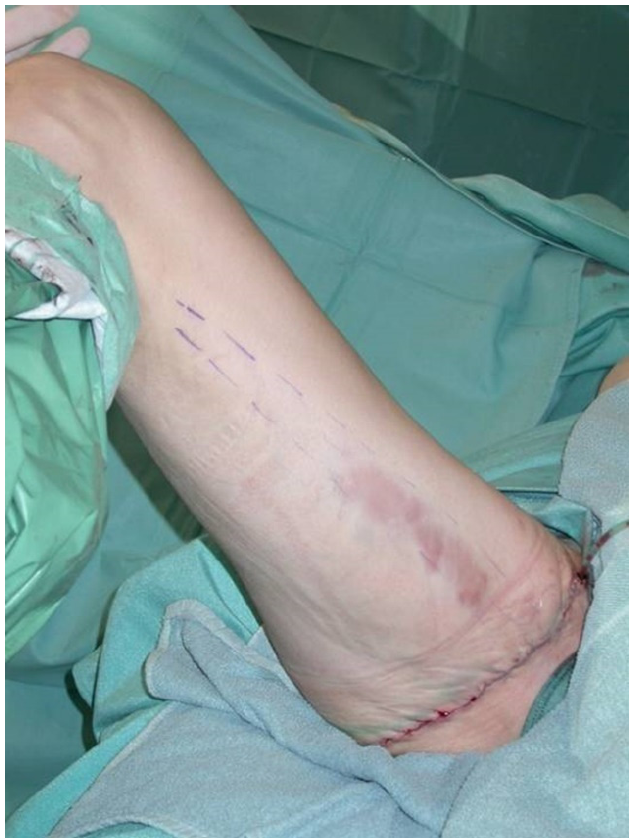
Figure 4. Intraoperative image after unilateral donor site closure.